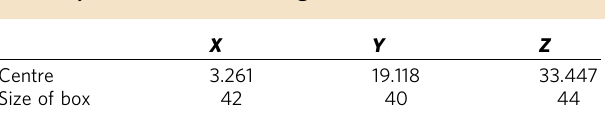
Table 2 | Parameters of docking